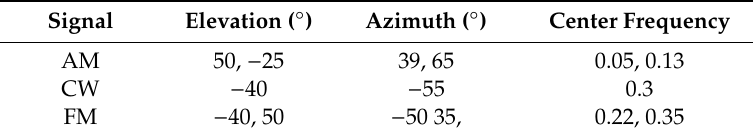
Table 5. Computer simulation scenario